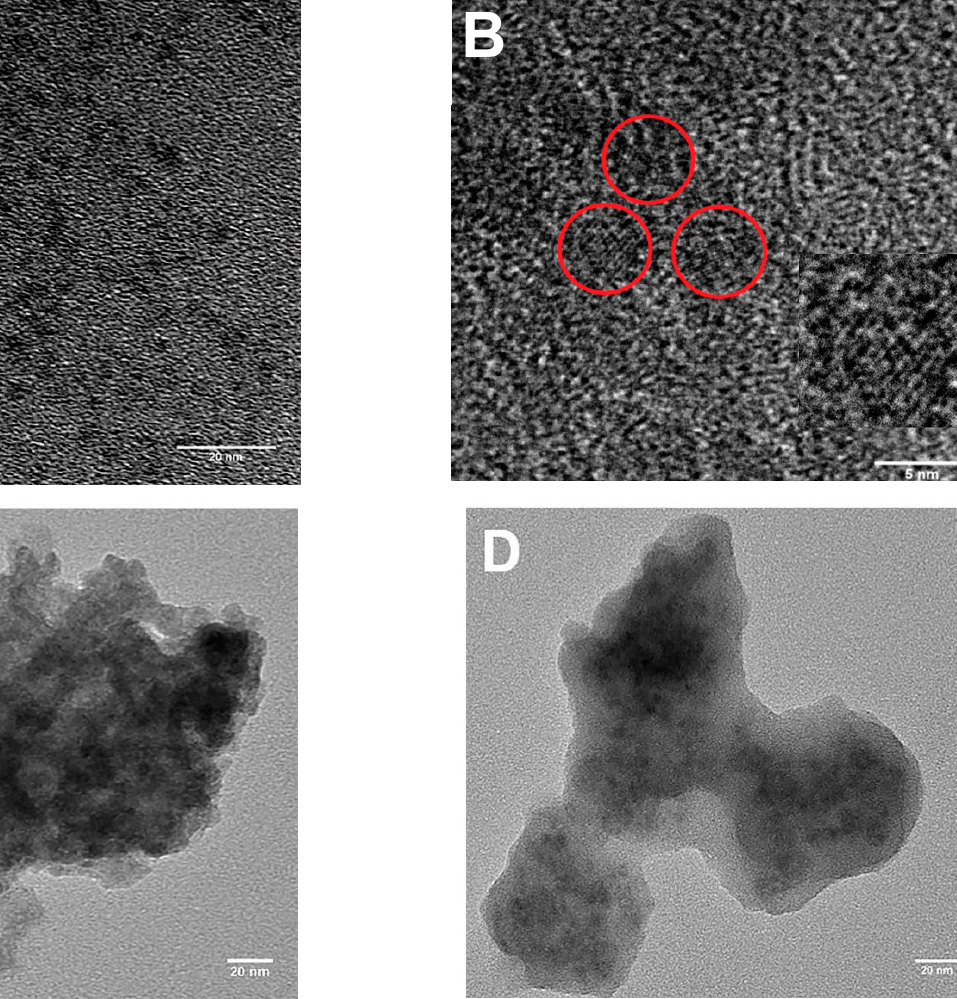
Figure 3. TEM images of the prepared APTES@Mn-ZnS QDs ( A ) and HRTEM images of APTES@Mn-ZnS QDs ( B ), MIPs@Mn-ZnS QDs ( C ) and NIPs@Mn-ZnS QDs ( D ).